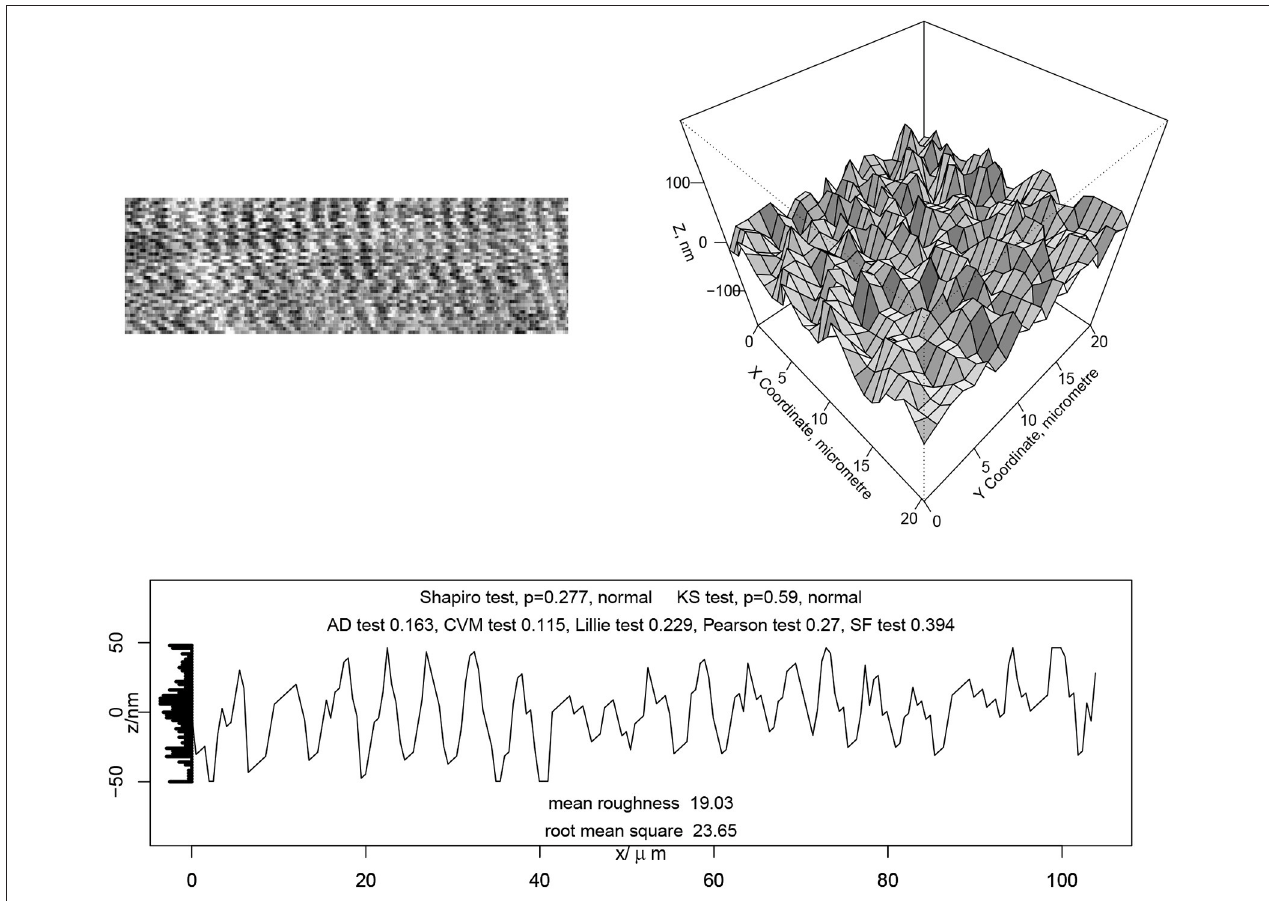
FIGURE 4 | The profilometer scan of the a-C sample. (Left) full measured patch 40 x 120 µ m . (Right) extracted small region 20 x 20 µ m . (Bottom) A typical profile with normality tests and two descriptive statistics (values are in nm): the root mean square (rms) and the mean roughness.